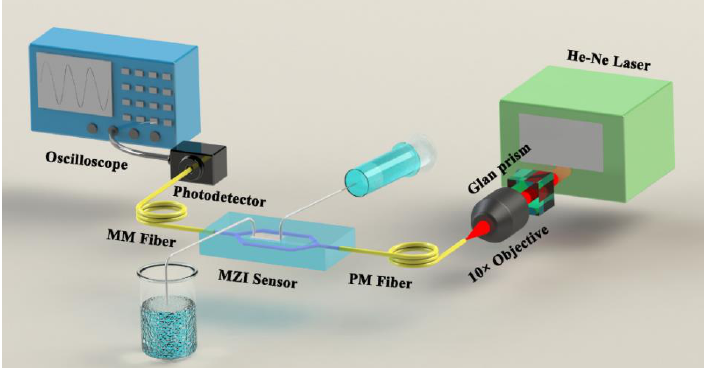
Figure 5. Schematic diagram of the MZI sensor measurement setup. PM fiber: polarization main-